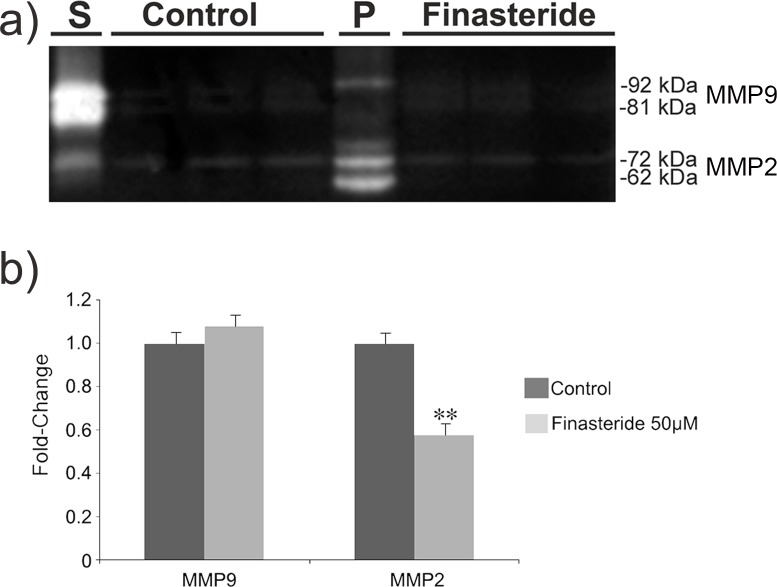
Finasteride’s effects on MMP2 and MMP9 activities in the conditioned medium of DU145 cells.
a) Conditioned medium (CM) of untreated (Control) and finasteride-treated DU145 cells was collected, concentrated and analyzed for MMP2 and MMP9 activities using a gelatin zymography assay. (S) Standards, (P) Tissue extract of a gastric ulcer that was used as a positive control. These cells secreted high quantities of MMP2 and MMP9 into their CM, as shown by the bright bands on the dark background. b) High-dose finasteride (50 µM) downregulated MMP2 activity up to 43% after 72 hours of exposure, as quantified using the ImageJ™ software. Data are expressed as a fold-change graphic of the IOD values that were obtained from the bands in the (a) figure for finasteride-treated cells over control cells. (**) Statistically significant values with p<0.01. Experiments were carried out in triplicate.